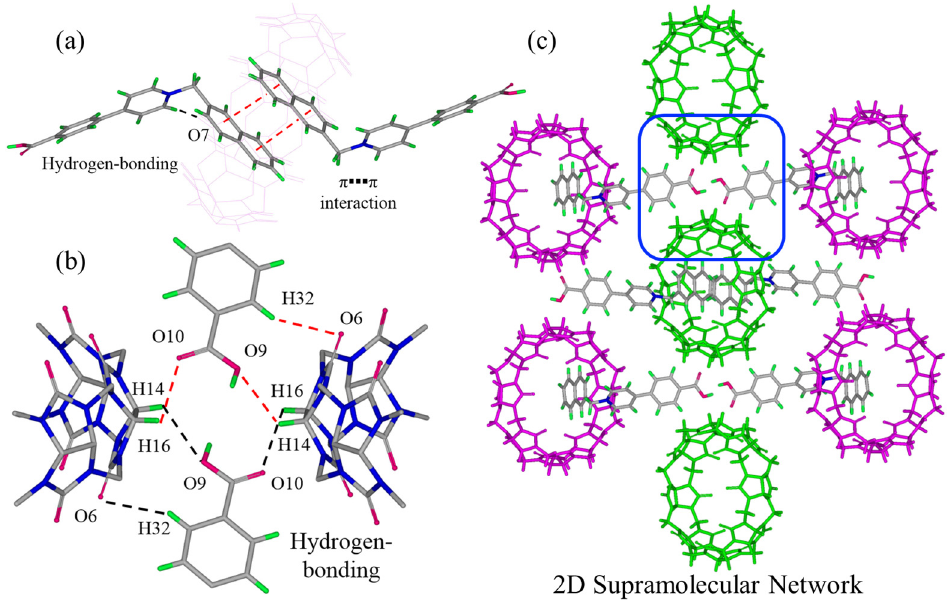
Figure 5. ( a ) X-ray crystal structure of the homoternary complex NapA 2 @Q[8]. Solvate water molecules were omitted for clarity. ( b ) The strong hydrogen-bonding between NapA and Q[8] molecules. ( c ) Two-dimensional supramolecular network of complexes.